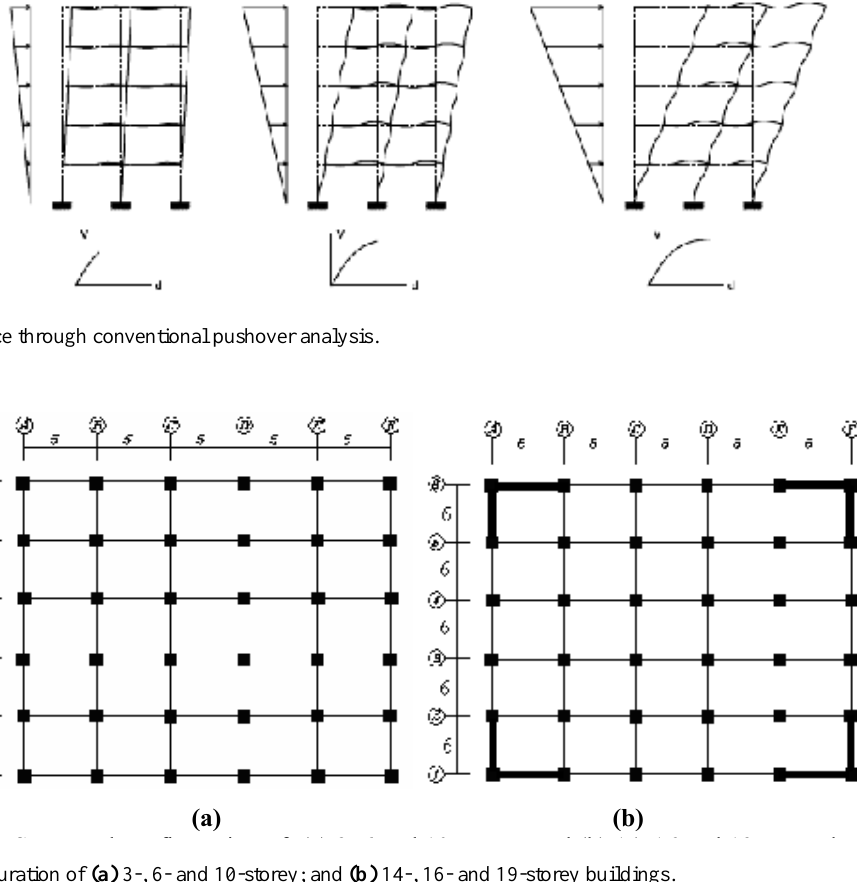
(b) Figure 8. Peak displacement profiles for the 3-storey building with (a) V/W=cte, (b) U top /H=cte